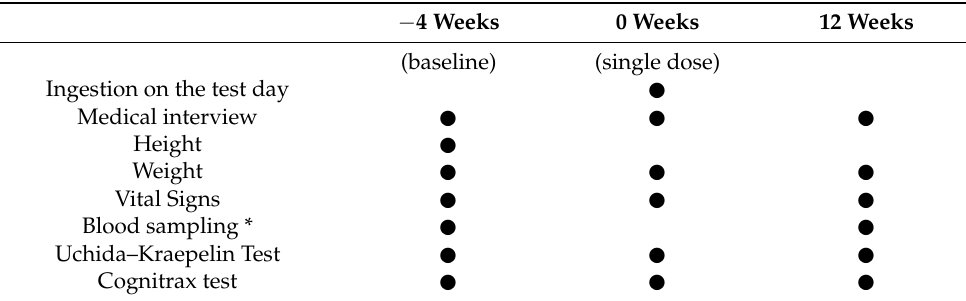
Table 2. Clinical trial evaluation